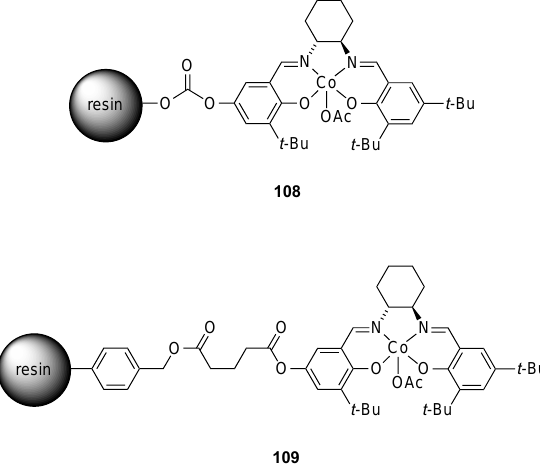
Figure 41. Resin-supported Co–salen catalysts 108 and 109 .